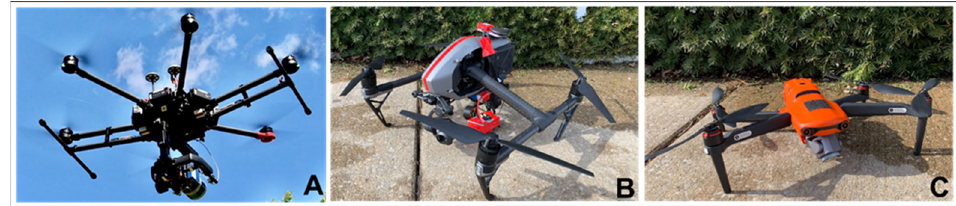
Figure 2. UAS sensor combinations used in the study: ( A ) DJI Matrice 600 Pro with Headwall Nano-Hyperspec VNIR and Velodyne Puck lite LiDAR sensors, ( B ) DJI Inspire II with MicaSense Rededge multispectral sensor, and ( C ) Autel Evo II with Sony 1” CMOS 20 RGB sensor. Multispectral data were acquired with a MicaSense Rededge-M sensor (MicaSense